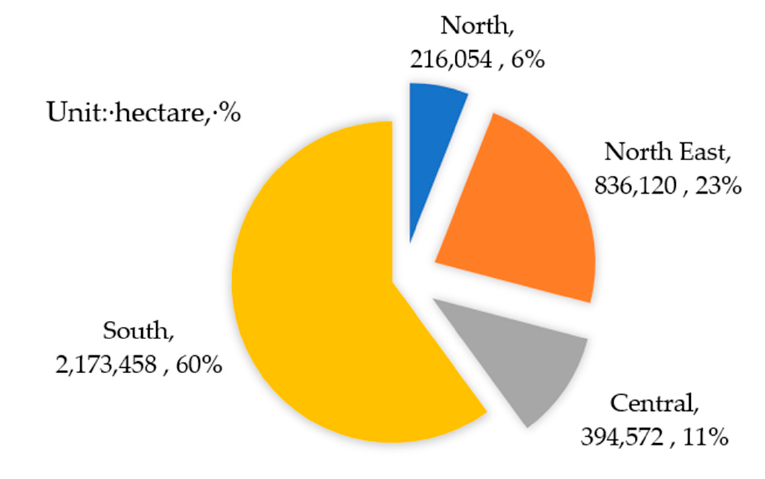
Figure 3. Para rubber production areas by regions of Thailand: 2018 (unit: hectare, %) [31].